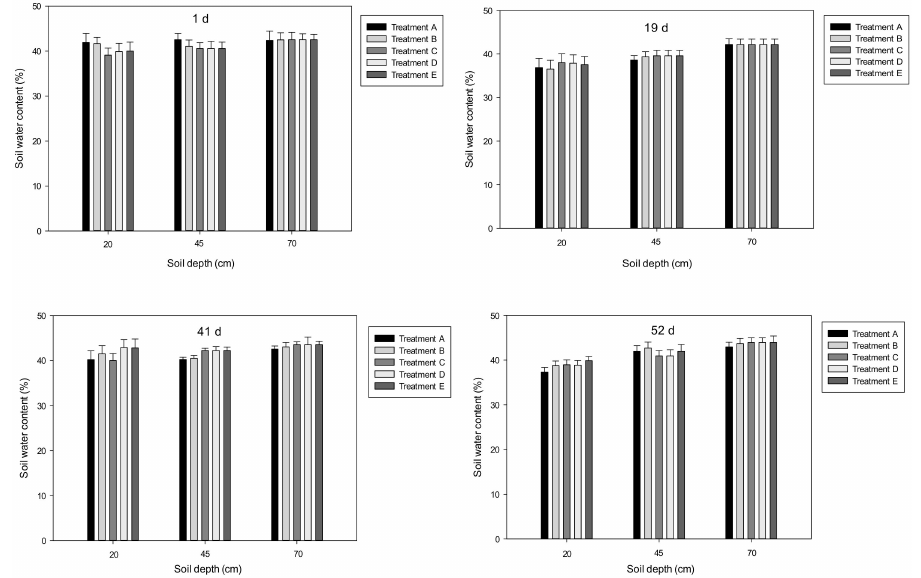
Figure 6. Variation in the soil water content of the soil profile in five